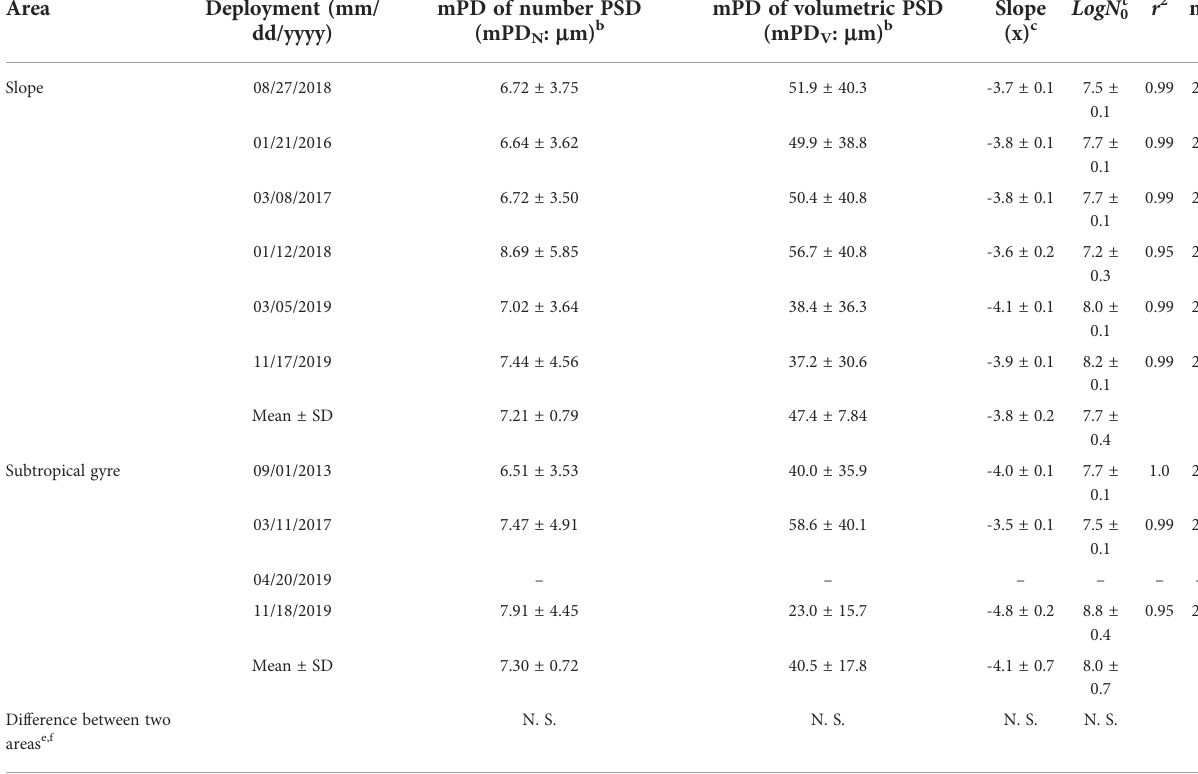
TABLE 5 Mean diameters of particles between 5.12 and 119 m m in diameter (mPD) and parameters of each regression line for the mean particle size distribution (PSD) in the euphotic layer a . Area Deployment (mm/ mPD of number PSD dd/yyyy) (mPD N : m m) b (mPD V : m m) b